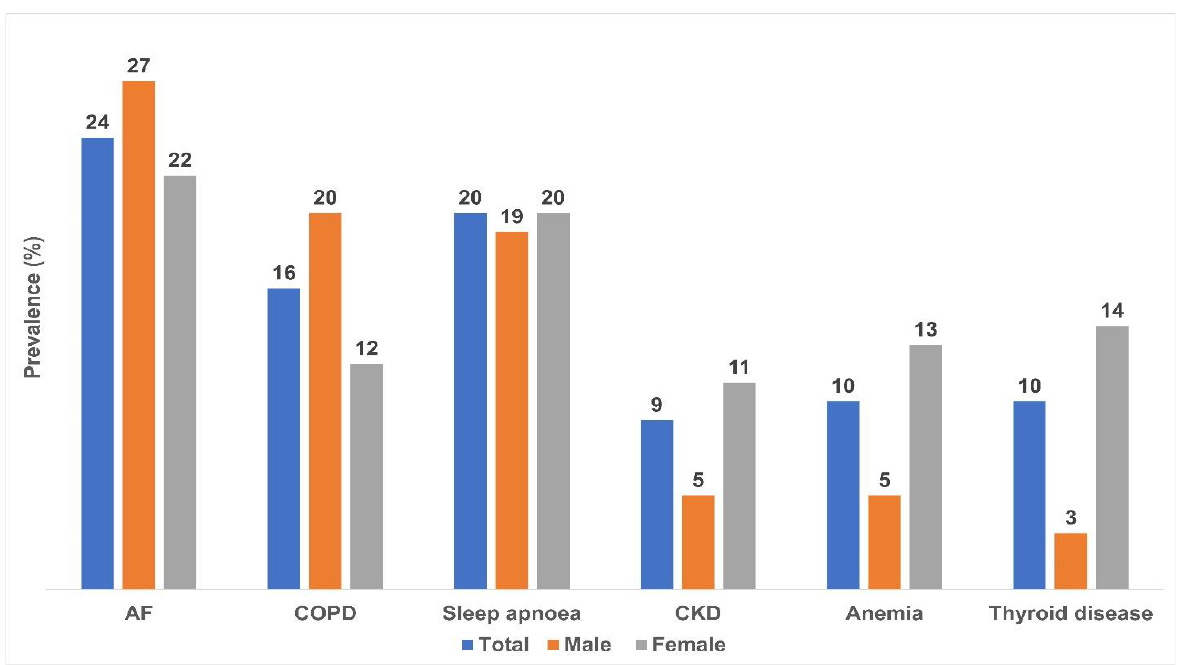
Figure 5. Sex-specific comorbidities in HF. Note: AF, atrial fibrillation; COPD, chronic obstructive pulmonary disease, CKD, chronic kidney disease. The horizontal axis shows comorbidities. The vertical axis shows prevalence rate expressed as a percentage.